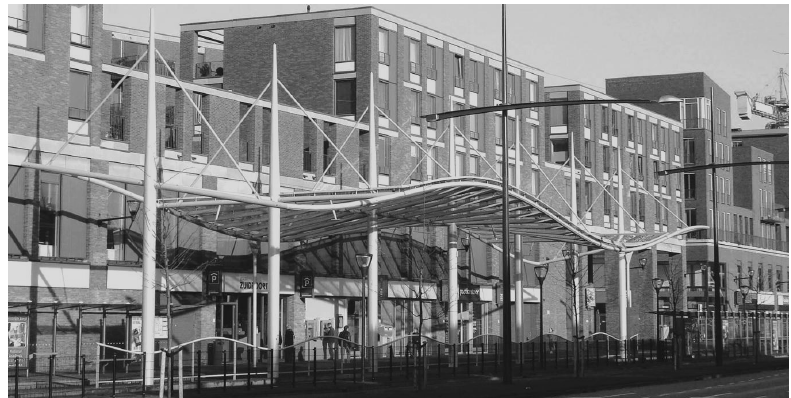
Figure 6: Top view Tramstation Zuidpoort. Figure 7: Draft Tramstation Zuidpoort.